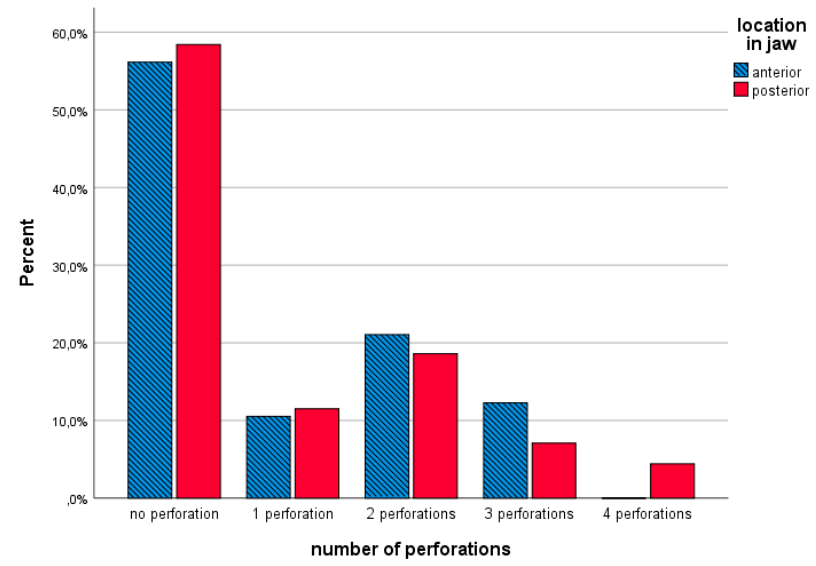
Figure 9. Perforation percentage in the anterior and the posterior jaw location.